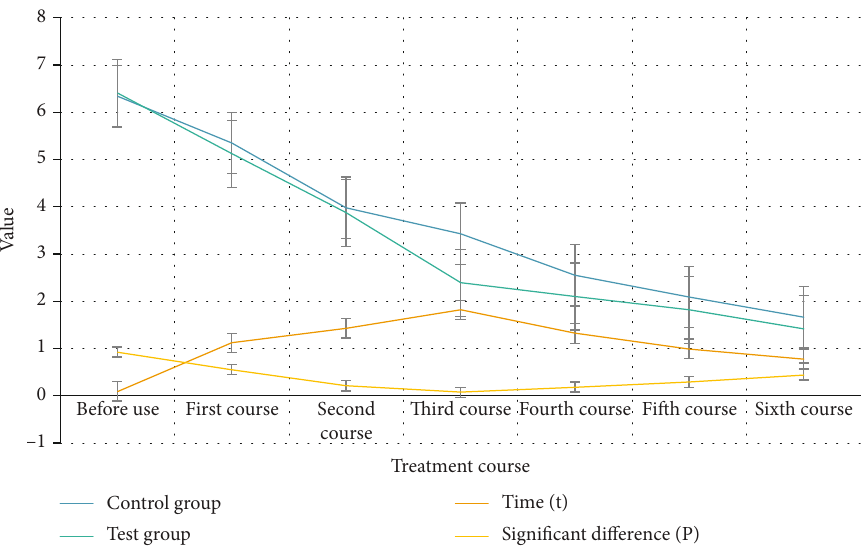
Figure 4: Comparison of depression between two groups of patients before and after